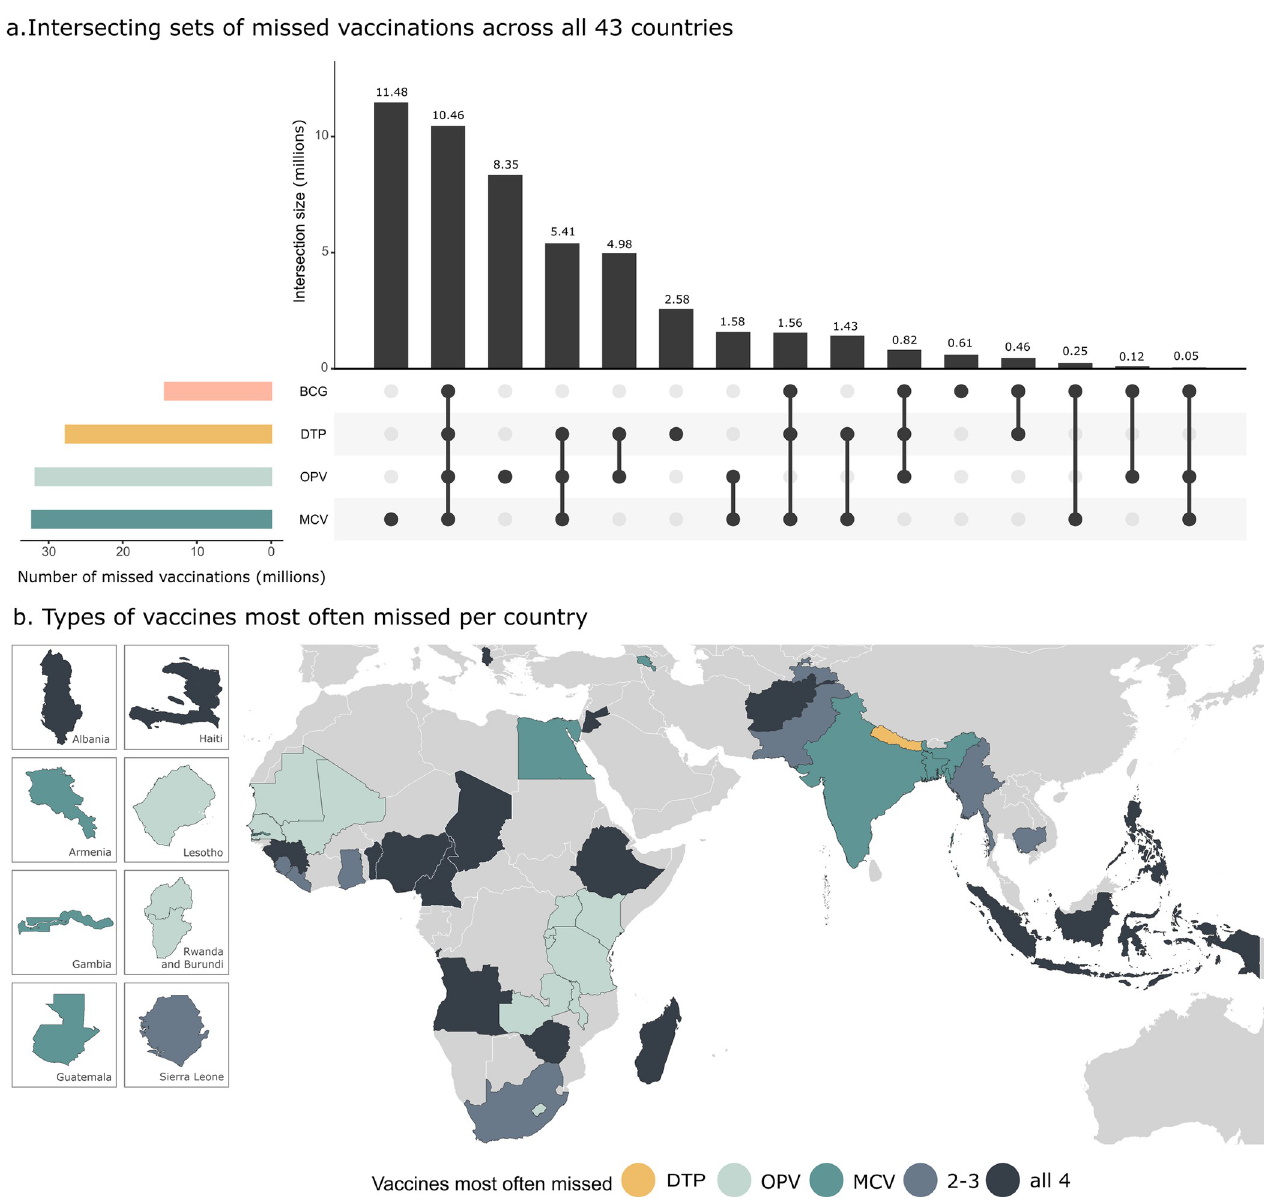
Fig 4. Intersecting sets of missed vaccinations among children aged 15 to 35 months across all 43 countries (a) and type of vaccines most often missed per country (b). In panel (a), the horizontal bars indicate the number of children aged 15 to 35 months that have missed each vaccination, and the dots and vertical bars indicate the combinations of vaccinations missed. Detailed country-level estimates are provided in S6 Fig. Note that multiple doses of DTP and OPV are needed to reach complete immunization. Spatial boundaries were retrieved from Natural Earth (https://www.naturalearthdata.com/) using the “rnaturalearth” package (https://github.com/ropenscilabs/rnaturalearth). BCG, bacille Calmette–Guerin vaccine; DTP, diphtheria–tetanus–pertussis vaccine; MCV, measles- containing vaccine; OPV, oral polio vaccine.